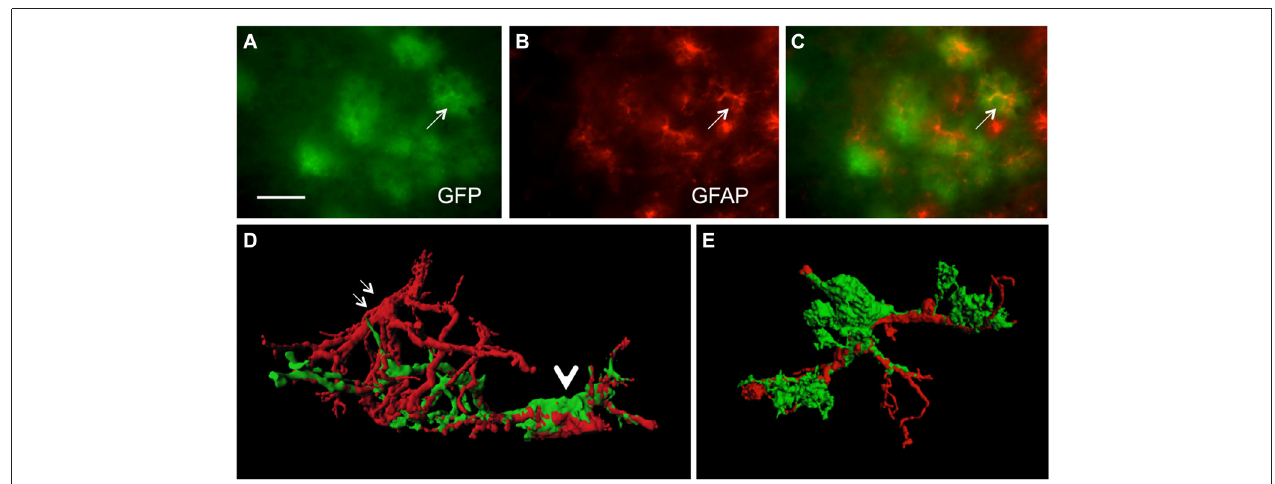
FIGURE 1 | Colocalization of green fluorescent protein (GFP) + and glial fibrillary acidic protein (GFAP) + astrocytes. Sections of amyloid precursor protein (APP)-Swedish-Dutch-Iowa (SweDI) × GFP-GFAP mice were immunohistochemically stained for GFAP (B–E) . In a cluster of reactive astroglia, many cells were double positive for both GFP (green, A ) and GFAP (red, indicated by an arrow, A–C ). However, some astrocytes were positive for either GFP or GFAP (A–C) . Confocal microscopy of brain sections clearly shows double positive astrocytes (indicated by a thick arrow D,E ) adjacent to an astrocyte being merely positive for GFAP (indicated by thin arrows, D ). Scale bar = 35 µ m (A–C) , 6 µ m (D,E) .